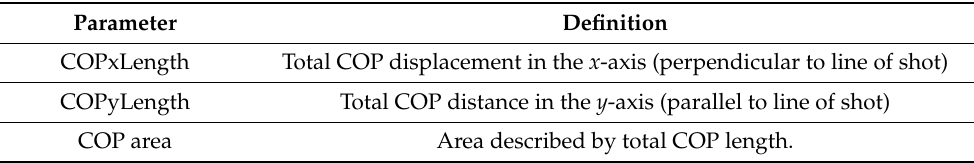
Table 2. Parameters indicating body sway of single-legged stance calculated from force plate